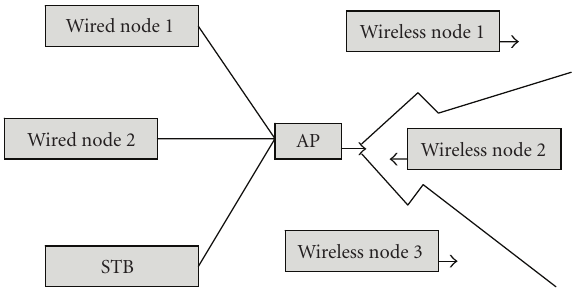
Figure 4: Simulation environment.